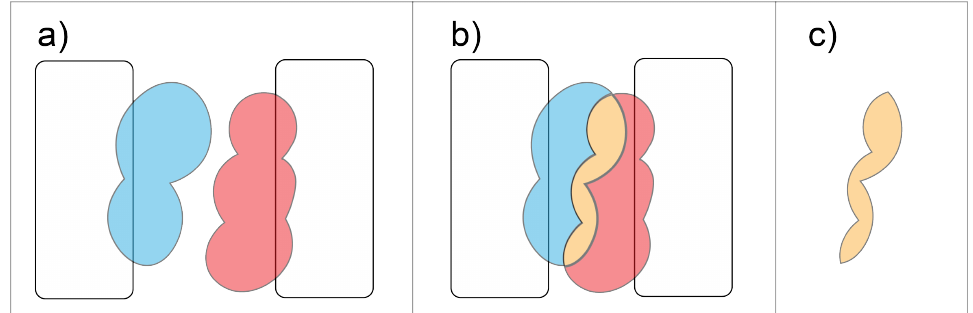
Figure 2. Intersection using CSG involves: ( a ) Two proteins with oppositely charged electrostatic fields. ( b ) When the proteins are in complex, the oppositely charged fields overlap forming an intersection region shown in orange. ( c ) The intersection region represents the degree to which the field of one protein complements the field of the other.